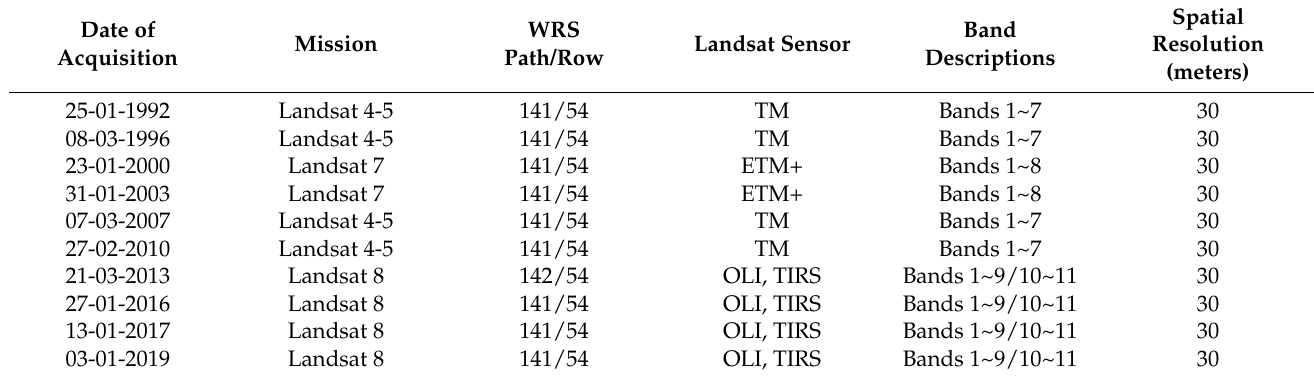
Table 1. Description of satellite imageries used in the